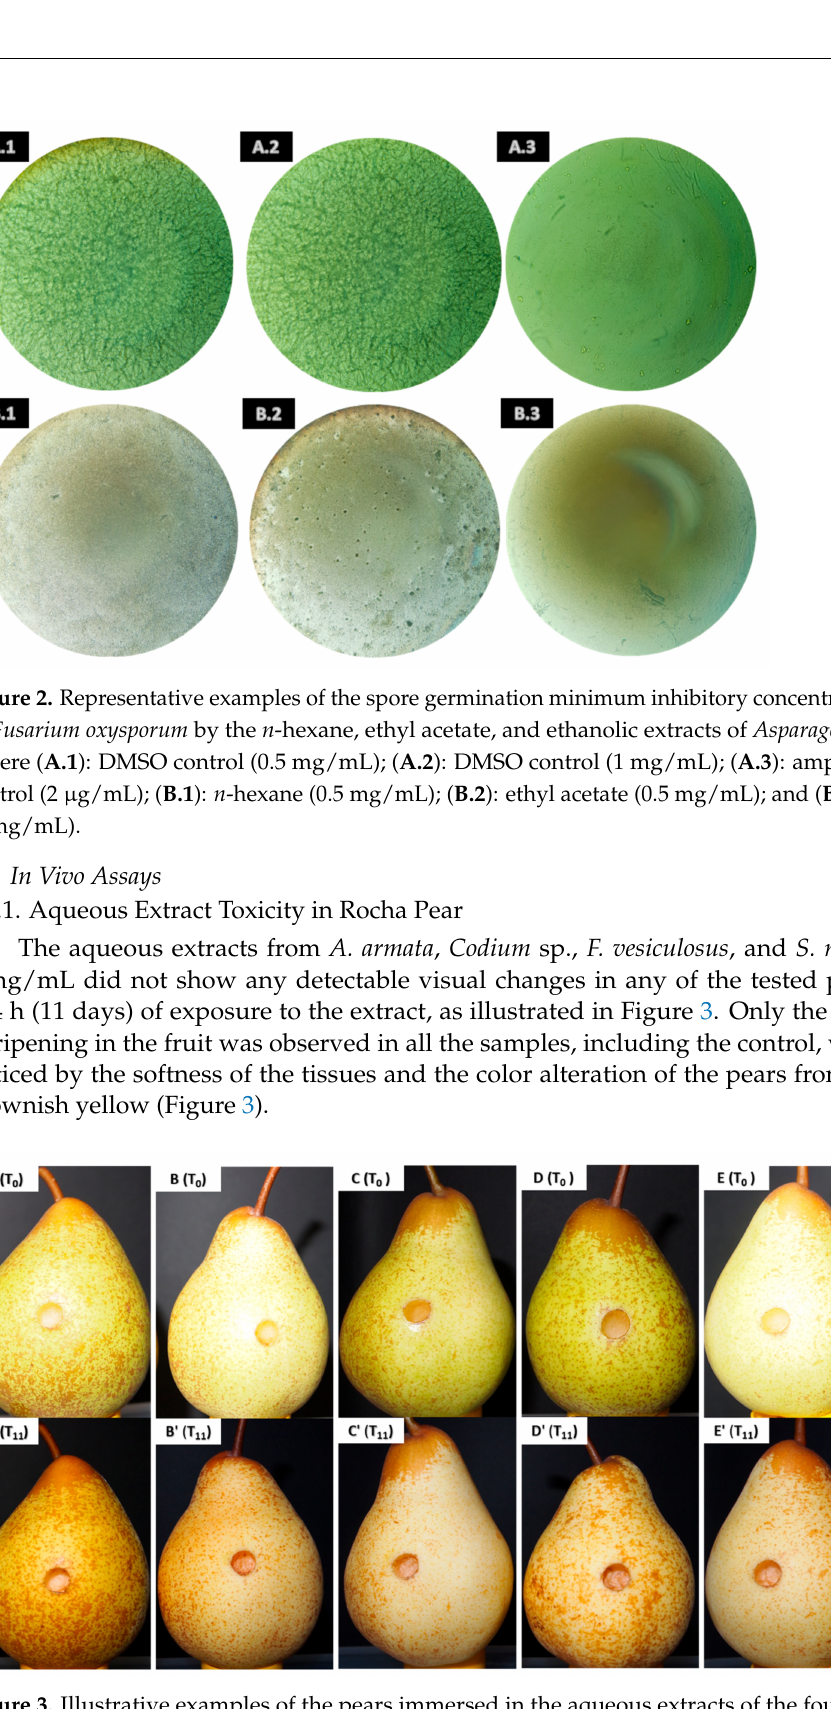
Figure 3. Illustrative examples of the pears immersed in the aqueous extracts of the four seaweeds at 1 mg/mL at the beginning of the experiment (T 0 ) and after 264 h of incubation (T 11 ). ( A , A’ ): Asparagopsis armata aqueous extract; ( B , B’ ): Codium sp.; ( C , C’ ): Fucus vesiculosus ; ( D , D’ ): Sargassum muticum; and ( E , E’ ): wounded pear without treatment